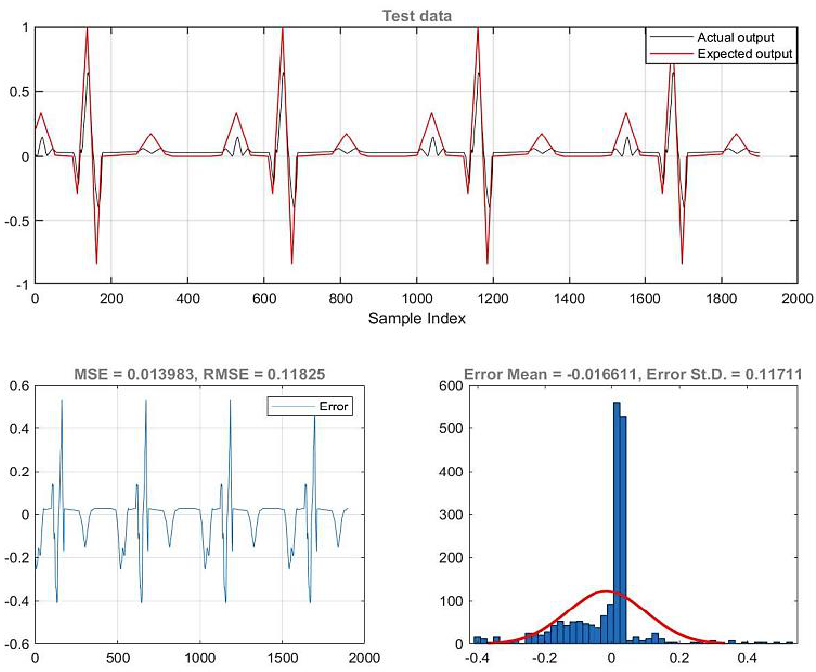
Fig. 4. The actual generated output with the expected validation output.